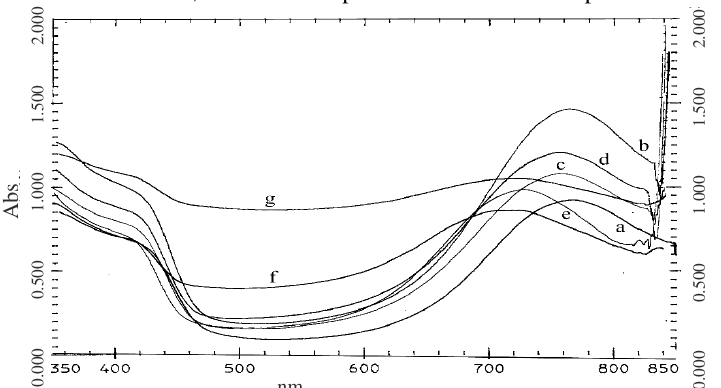
Figure 4. UV-Vis spectra of PAn (EB); (a) Before thermal treatment, (b) After heat treatment at 80 o C, (c) After heat treatment at 100 o C, (d) After heat treatment at 130 o C, (e) After heat treatment at 150 o C, the time of exposure at maximum temperature was 30 min.